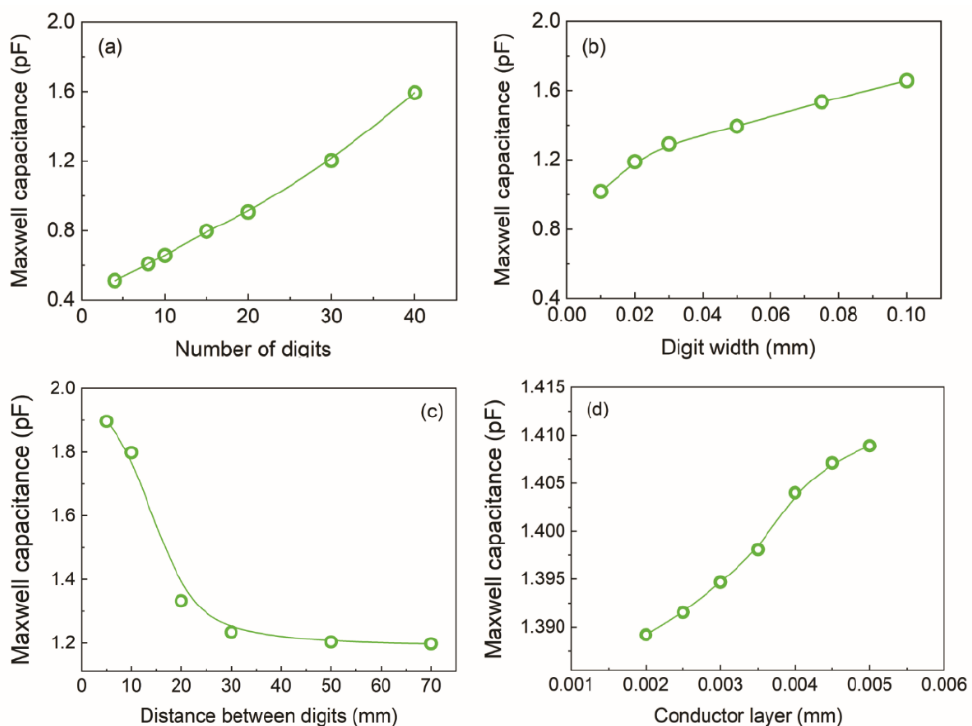
Figure 2. Maxwell capacitance as a function of the ( a ) number of digits, ( b ) digit width, ( c ) distance between digits, and ( d ) conductor layer of the interdigitated electrodes.